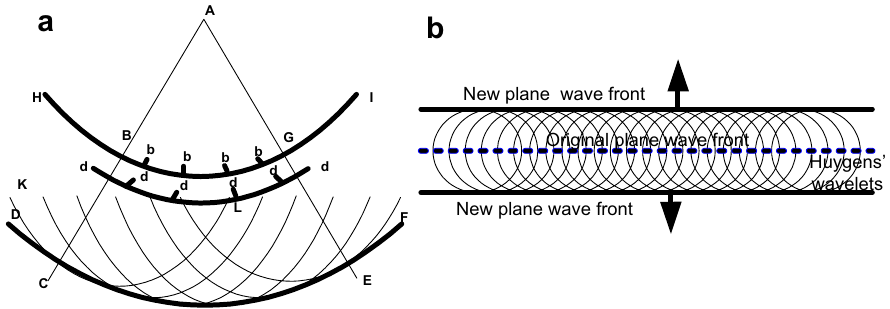
Figure 1. Huygens’ Principle as a geometrical construction. ( a ) A replica of Huygens’ original Figure1 (a spherical wave). ( b ) Huygens’ geometrical construction presented as a plane